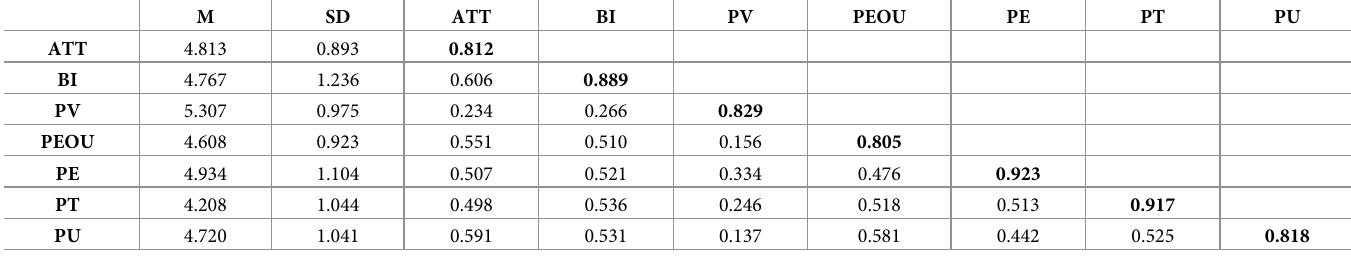
Table 3. Square root value between correlation coefficient and AVE of